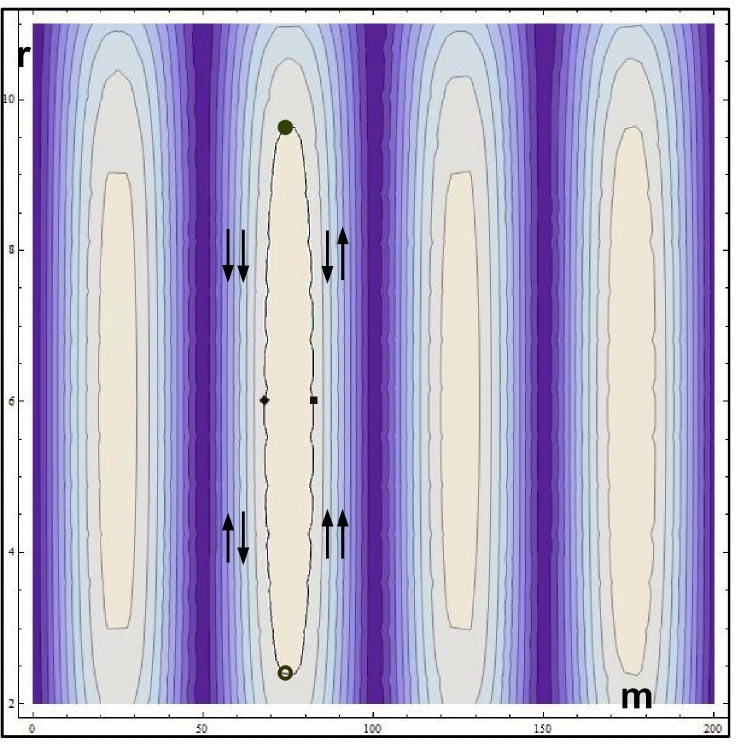
Figure 2. Success prob.: Red line for p = 1/ N ; Blue line for p = 1/ line for p = 1/ N , r = 2, a = 0.7, Renyi entropy: Blue dashed line for p = 1/